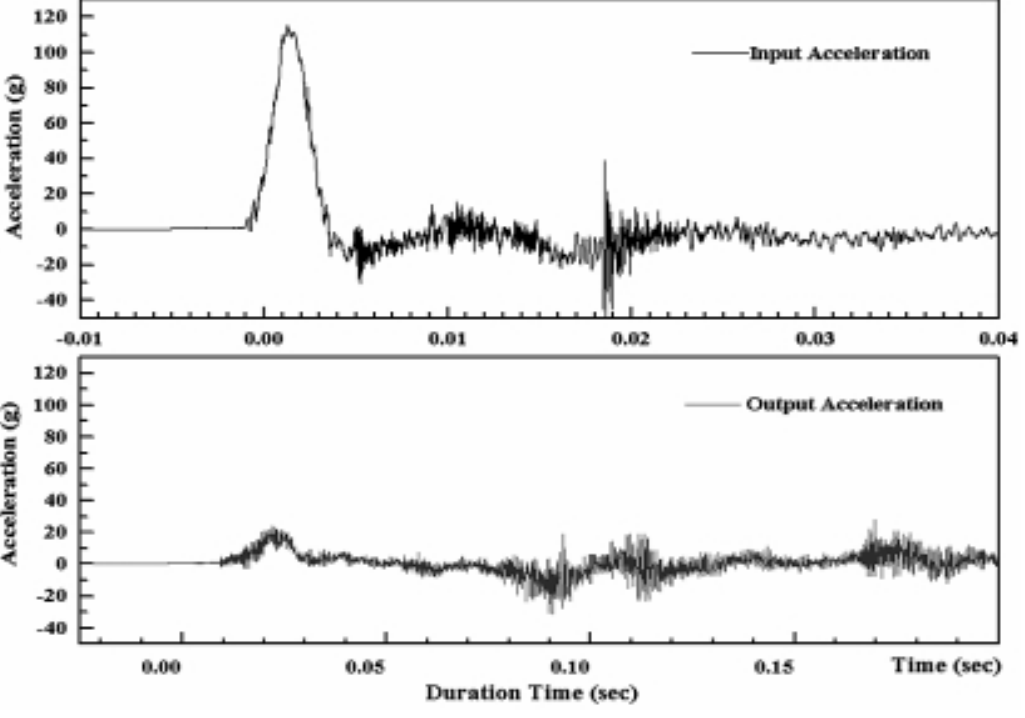
Fig. 3. Input-output response characteristics of test